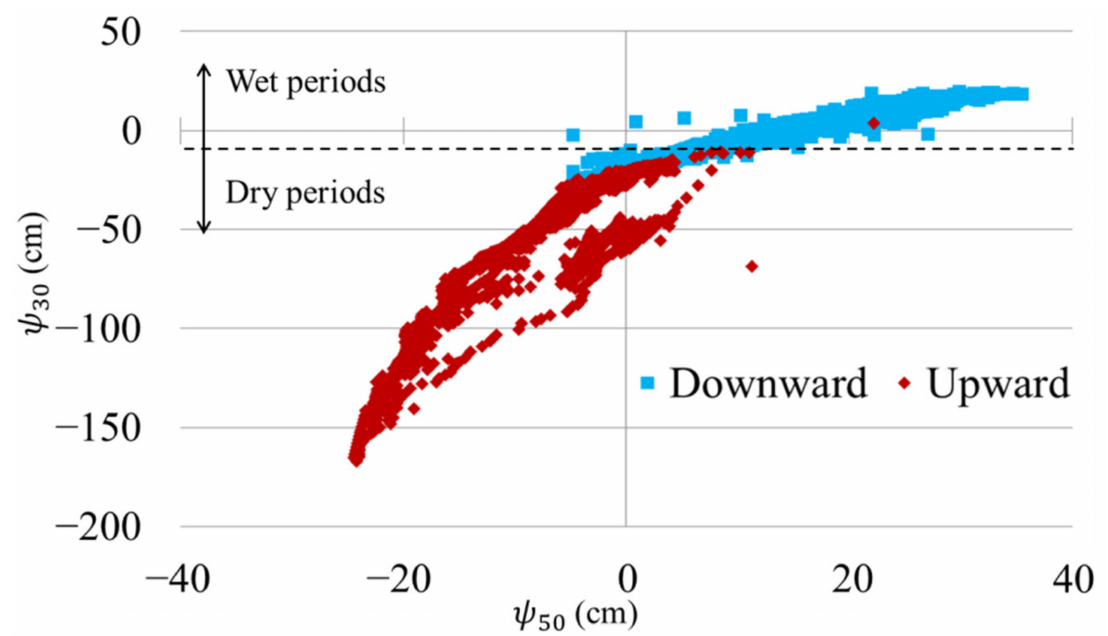
Figure 10. Relationship between simultaneous ψ 30 and ψ 50 observations. Dashed line represents ψ = − 10